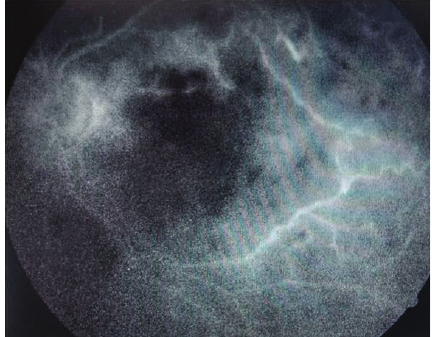
Figure 6: Fluorescein angiogram showing macular arteriolar occlu- sion with staining of the arteriolar walls along superior and inferior